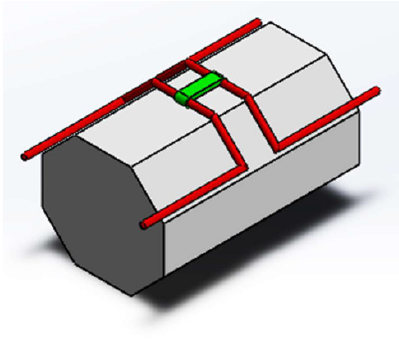
Figure 8. Closed configuration of the cage-based architecture.